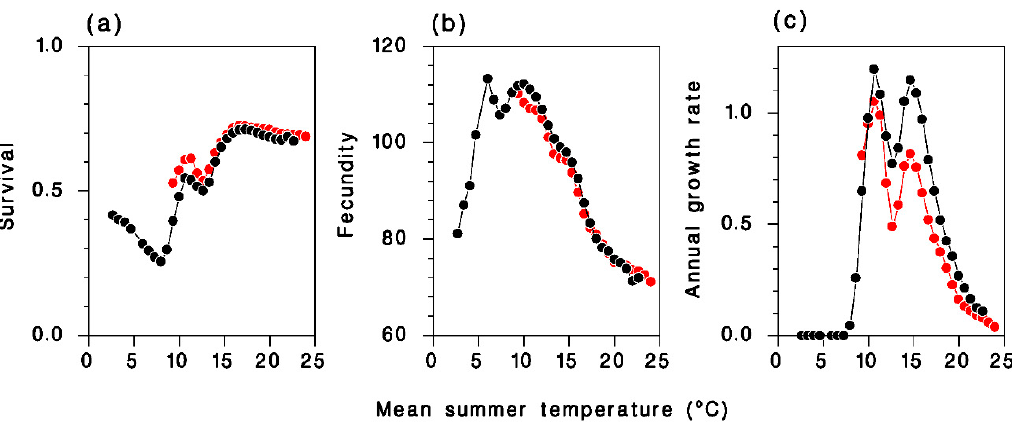
Figure 9. Compilation of average ( a ) survival of immatures, ( b ) fecundity of females, and ( c ) annual population growth rate (measured at the overwintering stage) relative to average summer air temperature (black: From daily air temperature records between 1981 and 2010; red: From climate-changed disaggregated normals 2011–2040). Lawrence River valley (Figure 10g).